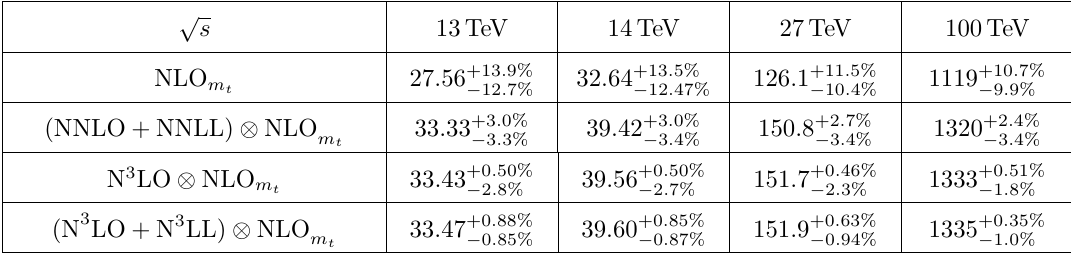
Table 2 . The inclusive total cross sections (in unit of fb) of Higgs pair production at 13 , 14 , 27 , 100 TeV after taking into account the NLO full top quark mass dependence. The quoted relative uncertainties are from the 7-point scale